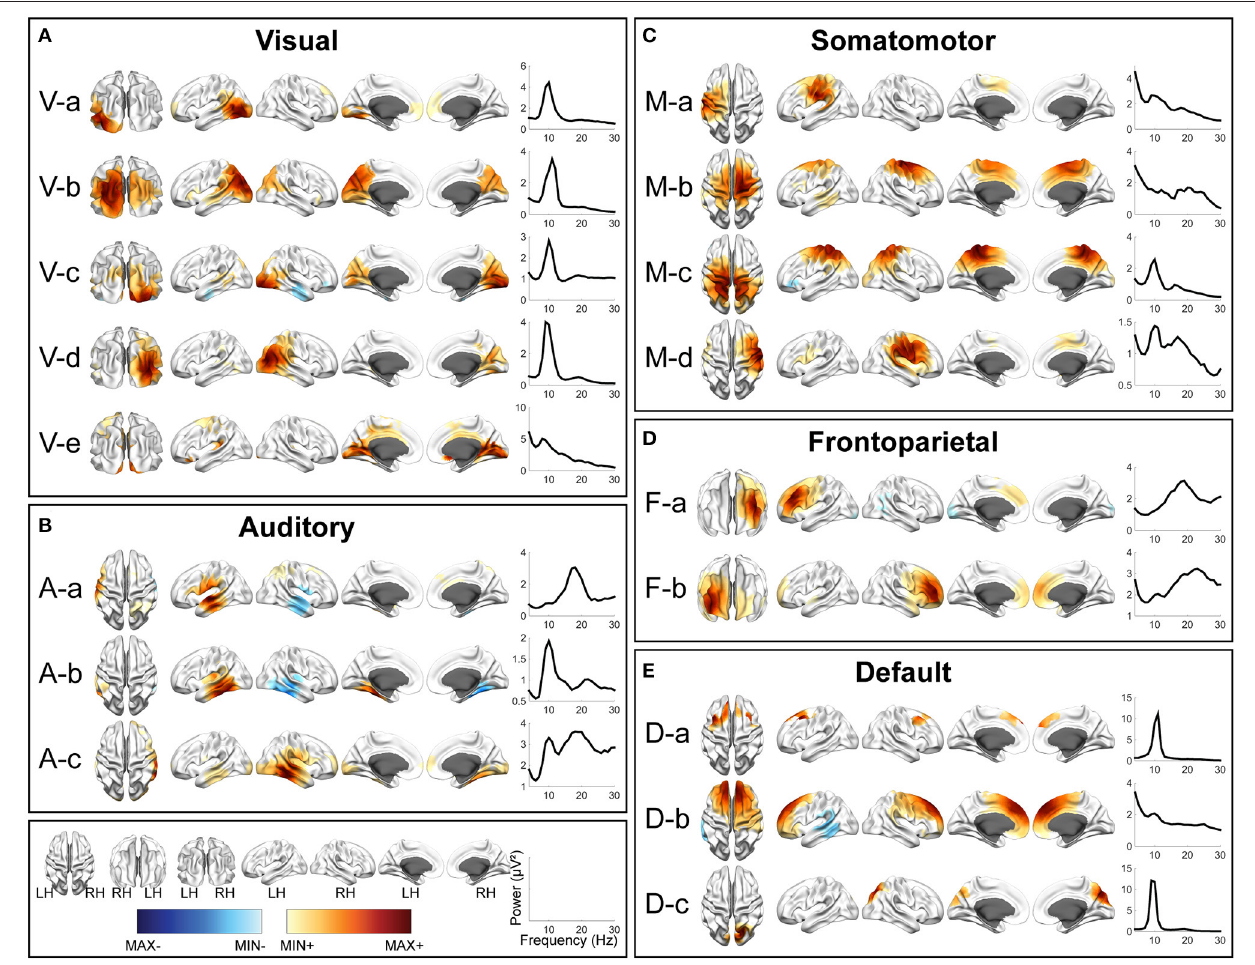
FIGURE 3 | Spatial and spectral patterns of five RSN classes from TFICA-SCT on the HC/MdDS EEG data. (A) Visual, (B) auditory, (C) somatomotor, (D) frontoparietal, and (E) default mode networks. Group-level SCT maps were thresholded at p < 0.01, cluster-based correction.